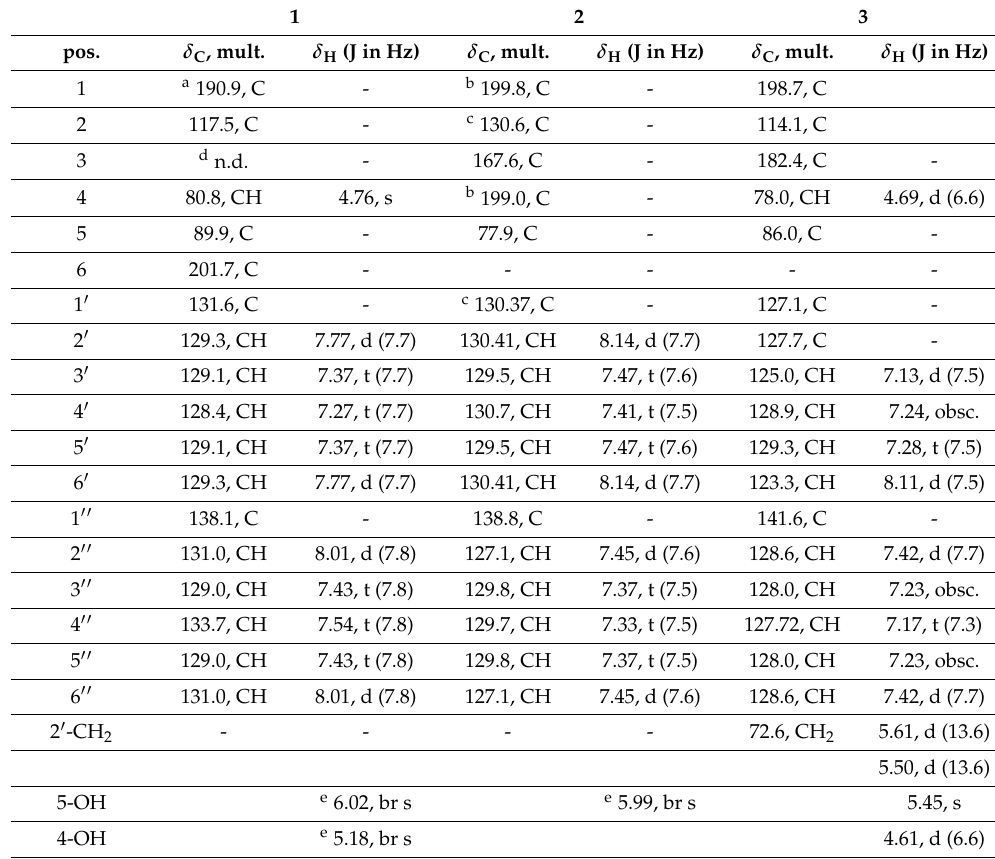
Table 1. 1 H- and 13 C-NMR data (600 and 150 MHz, respectively) for compounds 1 – 3 at 30 ◦ C ( 1 – 2 in MeOH- d 4 , and 3 in THF- d 8 ).